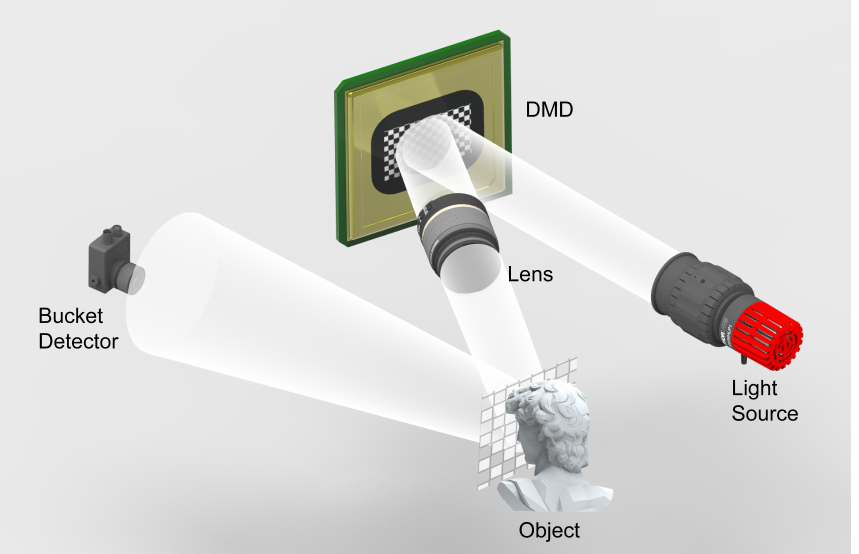
Figure 1. Schematic diagram of an SPI system. In an SPI system, DMD is illuminated by a light source such as an LED or collimated laser beam to produce illumination patterns, which are then projected to object through imaging lens. After interaction with the object, light is measured by a bucket detector. The image can be retrieved by a correlation calculation between illumination patterns and the corresponding detection